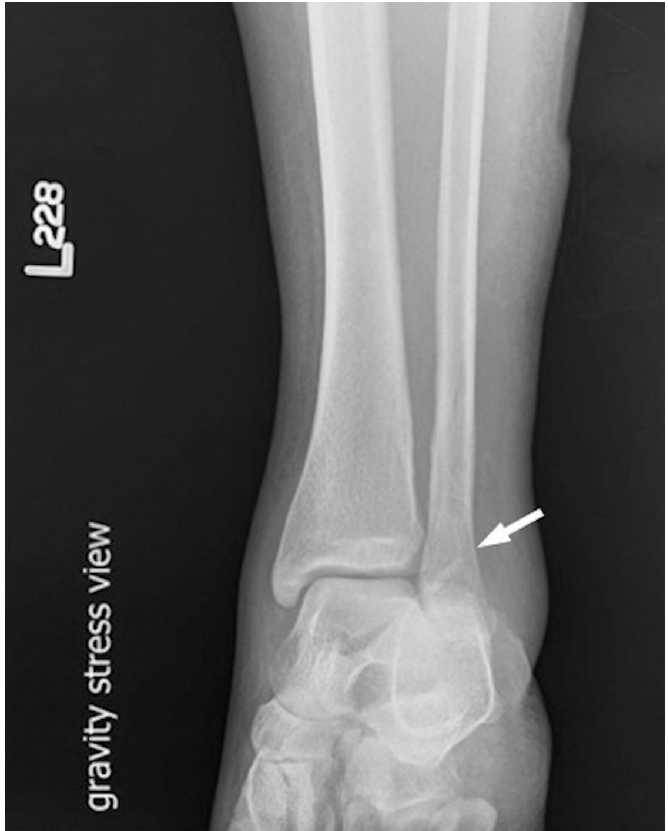
Image 2. Stress view radiography of the ankle demonstrating an irregularity of the lateral malleolus cortex consistent with a non- displaced Weber B